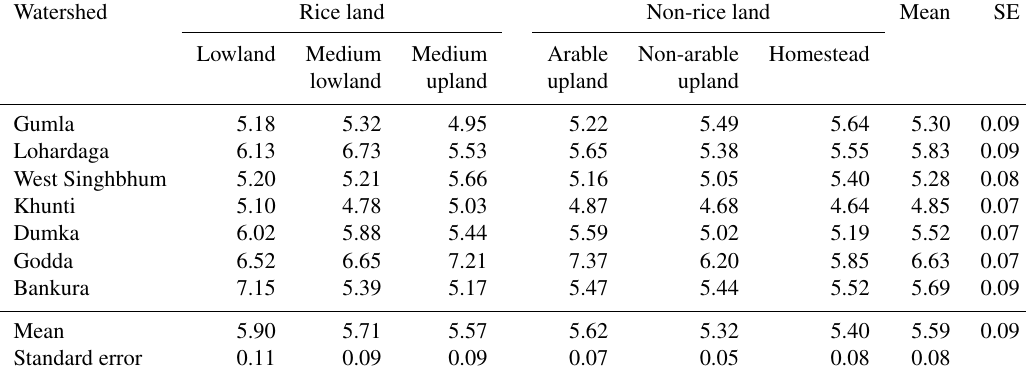
Table 2. Organic carbon (%) in seven EIP watersheds. Watershed